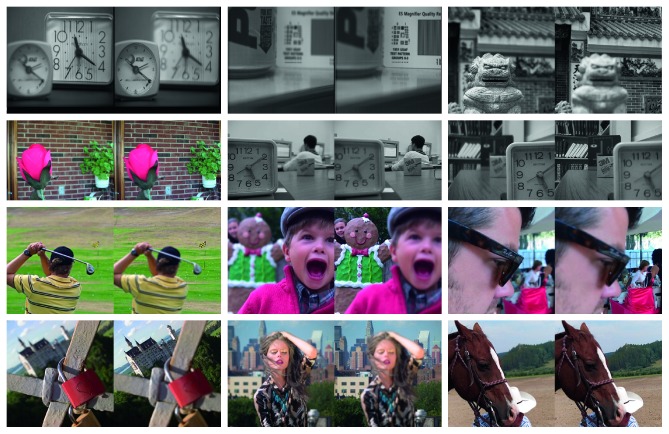
Partial test image.